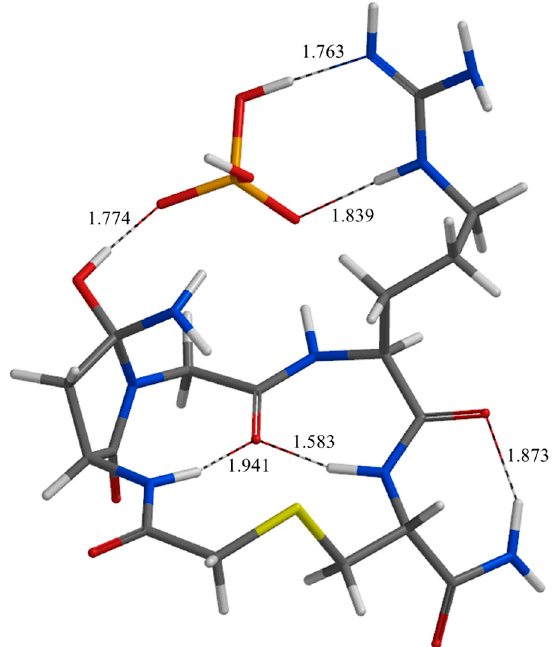
Figure 8. The geometry of TS3 (transition state 3) connecting IC2 (Figure 7) and IC3 (Figure 9). Selected interatomic distances are shown in Å. Grey: carbon; white: hydrogen; blue: nitrogen; red: oxygen; orange: phosphorus; yellow: sulfur.